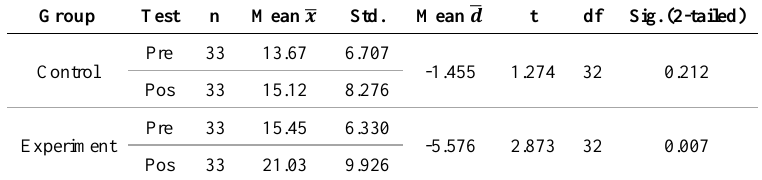
Table 8. Creative imagination scores before and after learning by the experimental and control groups